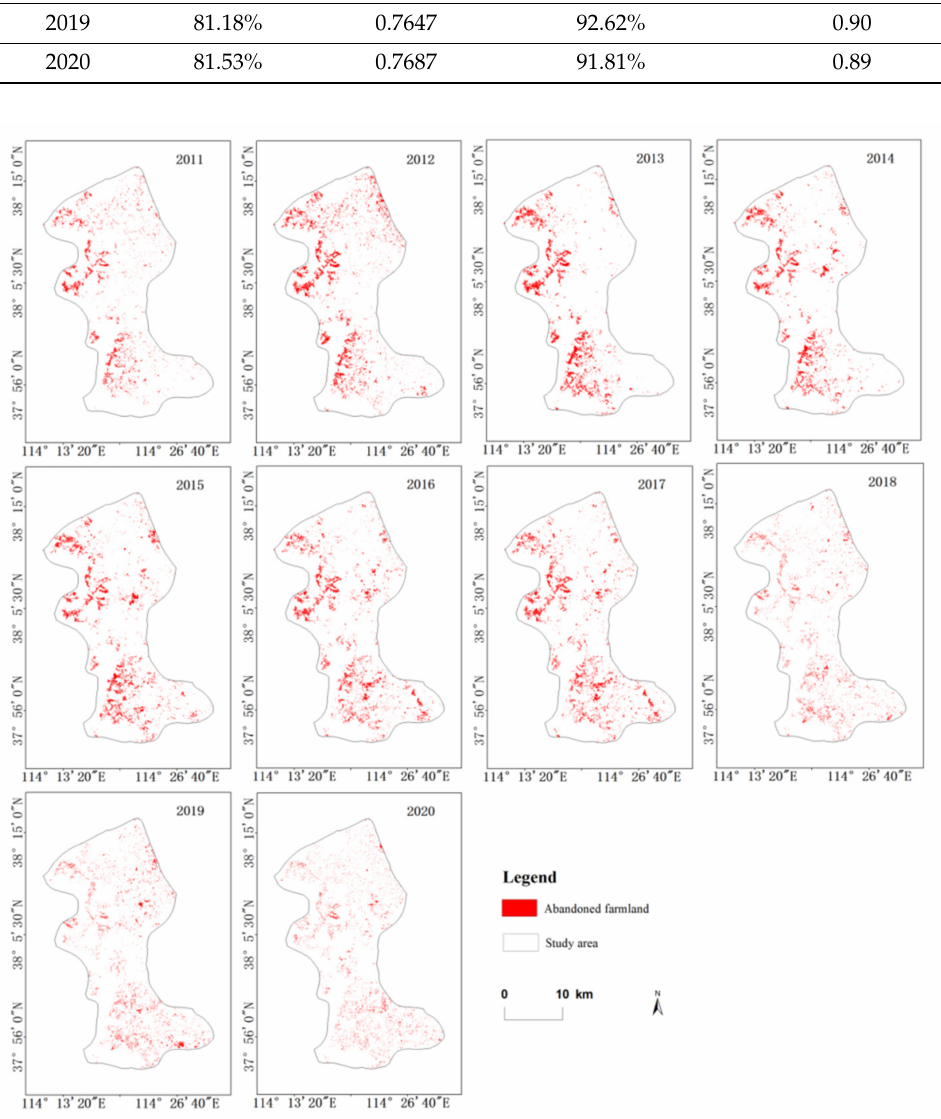
Figure 6. Abandonment time-series distribution map in Luquan for the period of